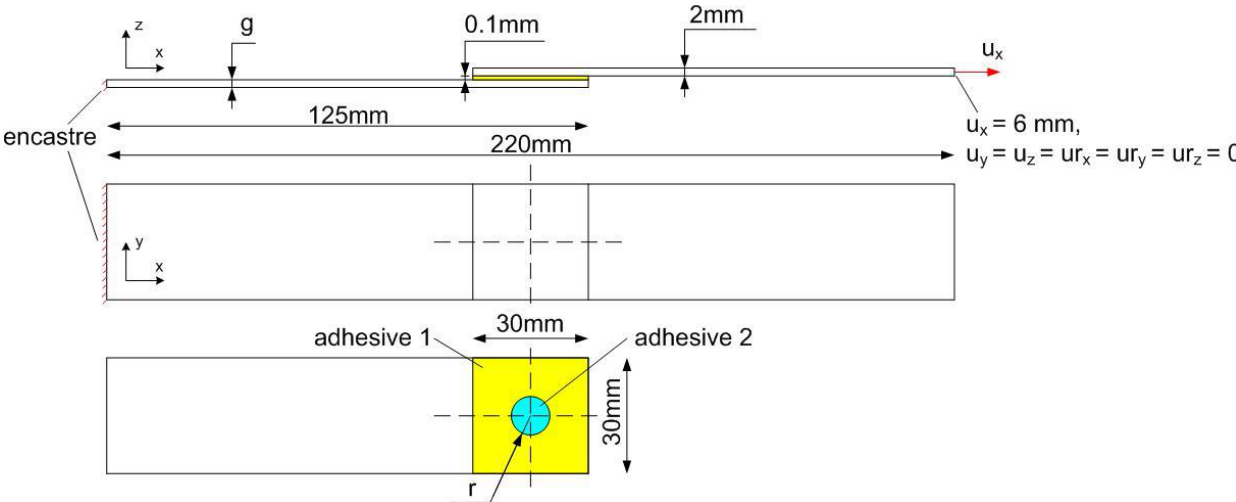
Figure 1. Single lap joint geometry.